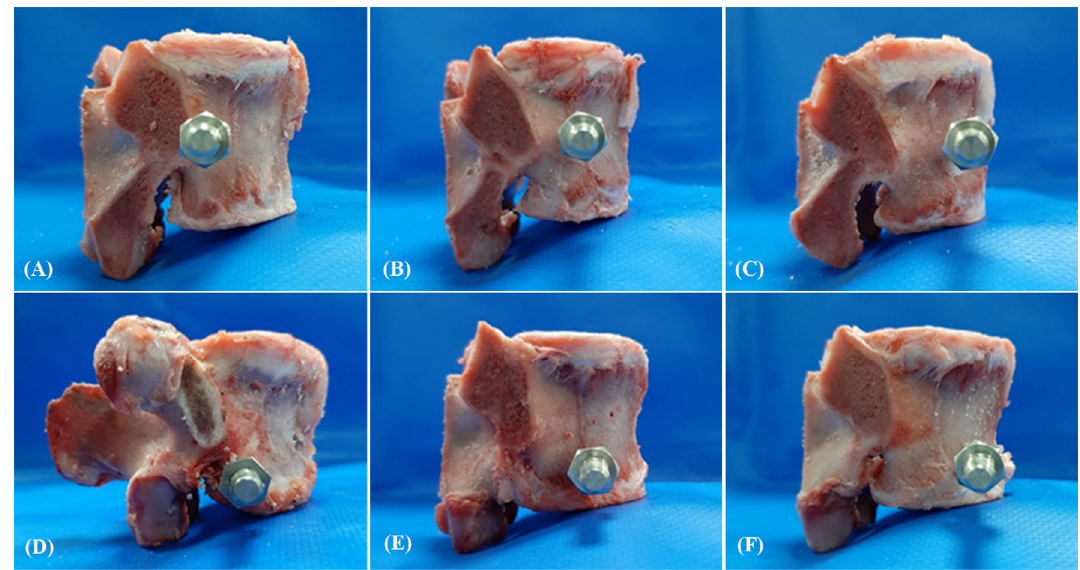
Figure 2. Photographs showing the sagittal view of the porcine vertebrae with various screw insertion positions. ( A ) C-p, ( B ) C-m, ( C ) C-a, ( D ) L-p, ( E ) L-m, and ( F )